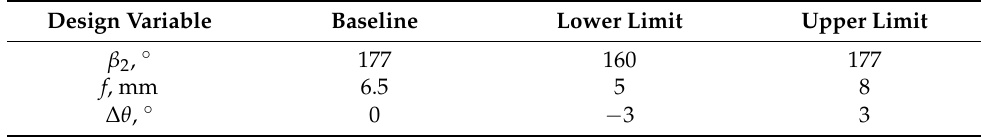
Table 2. Variation range of design